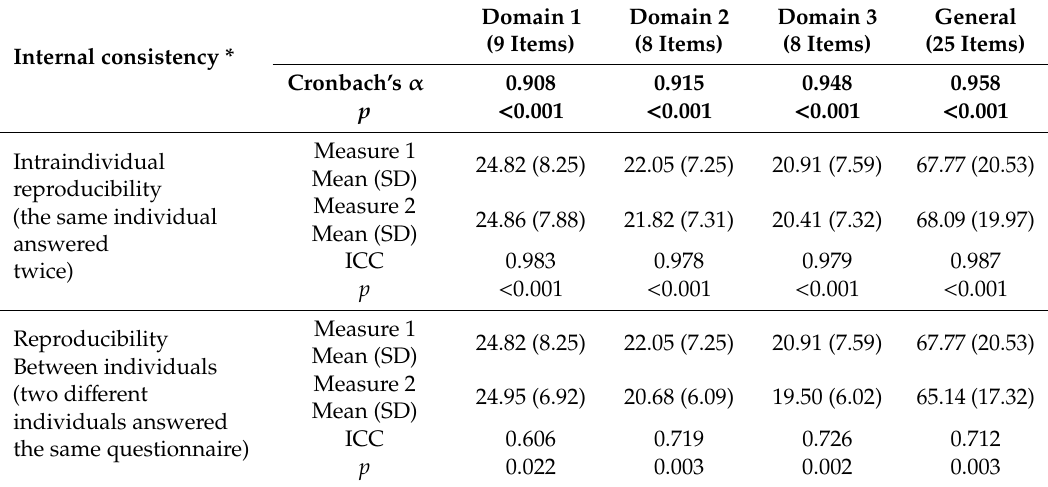
Table 1. Measures of internal consistency and intraindividual reproducibility and between individuals, according to each domain of the instrument. Brazil, 2020. ( n =